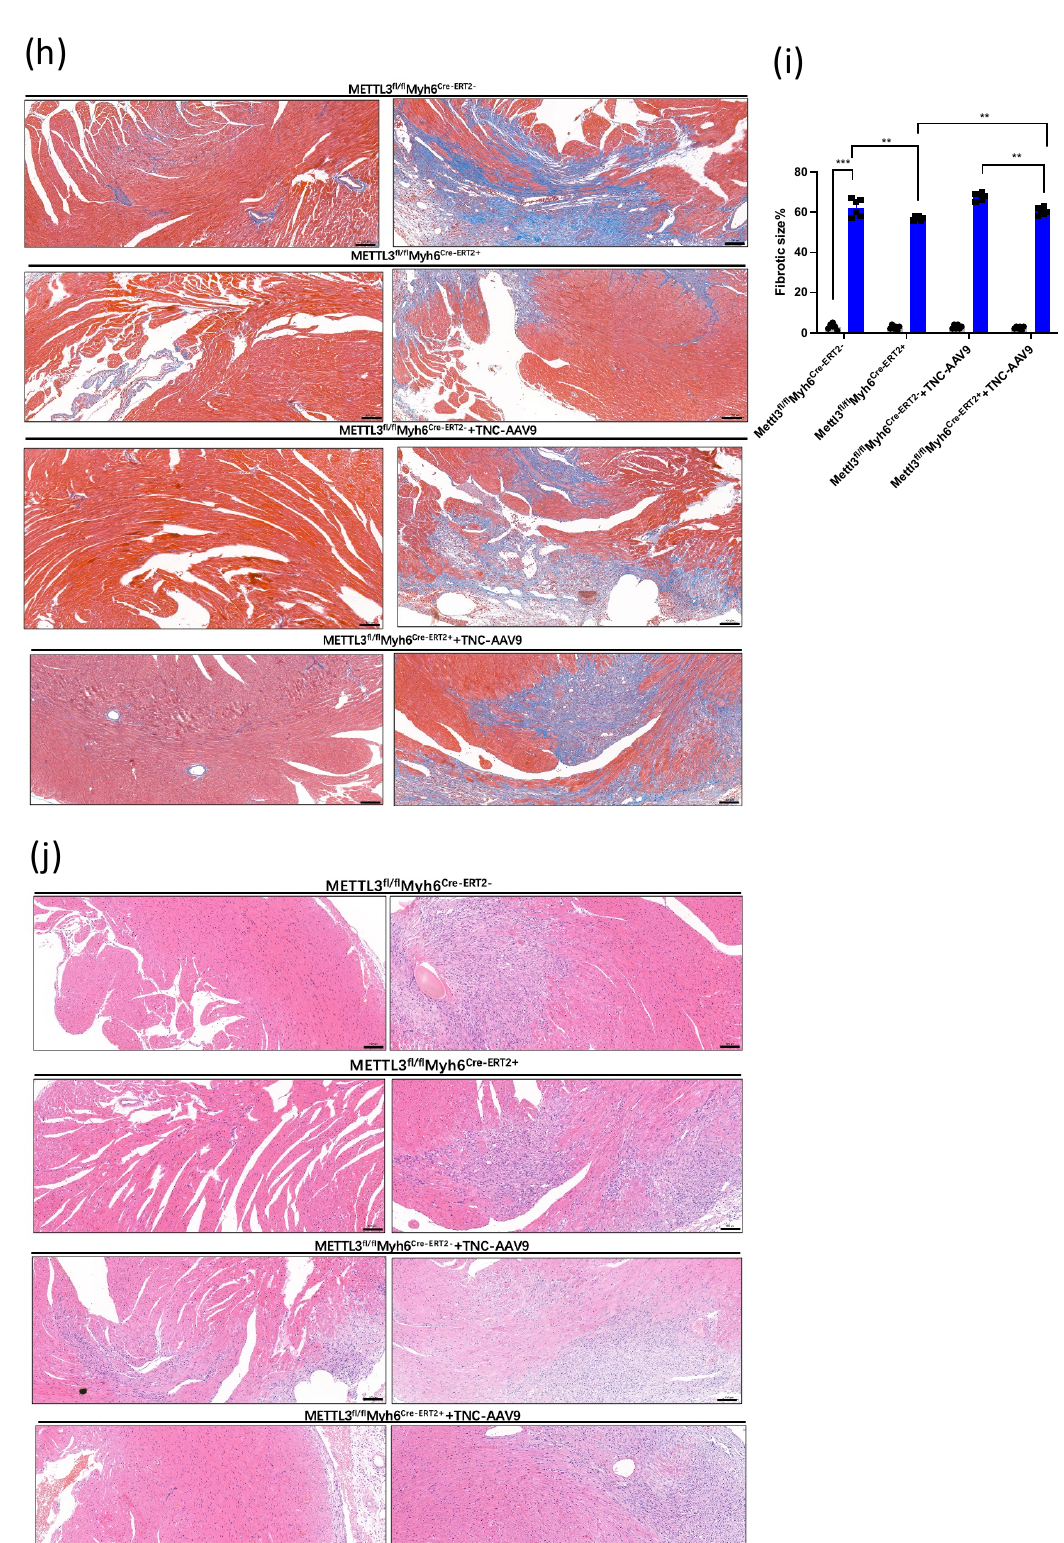
Figure 4. TNC overexpression in CKO- METTL3 mice greatly contributes to the cardiac dysfunction and myocardial infarction. ( a , b ) cell death in tissue samples was characterized by TUNEL assay scar bar: 50 um, ( n = 6); ( c ) representative photographs of M-mode echocardiography; ( d – g ) quantitative analysis of echocardiography. FS, fractional shortening; EF, ejection fraction; LVIDd, left